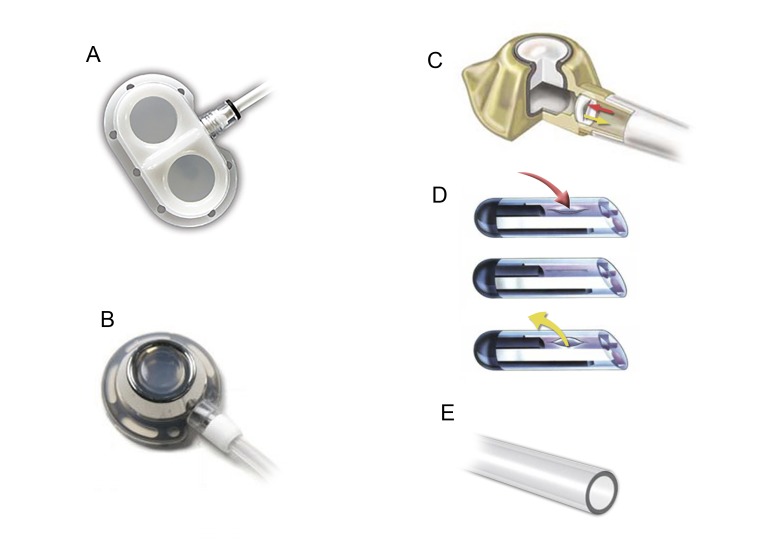
Types of totally implantable catheter (ports). (A) Double-chamber plastic port; (B) Single metal port; (C) Valve located in port; (D) Valve at end of closed-tip catheter. Negative pressure opens the valve, allowing blood to be drawn. At rest, the slit remains closed. Positive pressure, in turn, opens the valve to allow infusion of medications; (E) Open-tip catheter without valve.